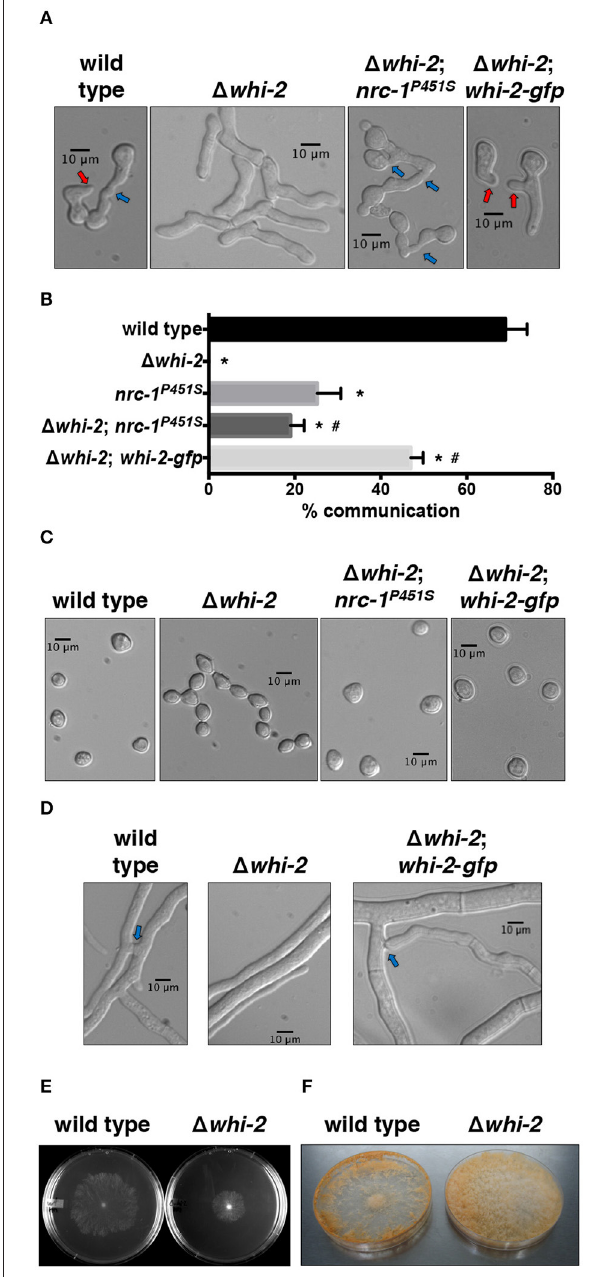
FIGURE 1 | Cell fusion and conidiogenesis defects observed in a 1 whi-2 mutant can be partially rescued by the introduction of a constitutively active allele of nrc-1 . (A,B) Cell-cell communication was analyzed by observing brightfield microscopy (A) of closely positioned germlings 4h post-inoculation. Red and blue arrows indicate conidial anastomosis tubes (CATs) and cell communication/fusion events, respectively. The relative frequency of cell-cell communication is shown in (B) . Error bars represent the standard deviation. * p -value < 0.0001 vs. wild type; # p -value < 0.001 vs. 1 whi-2. (C) Conidial morphology was assessed in WT and whi-2 strains using brightfield microscopy. Note the presence of proconidial chains in the 1 whi-2 strain. (D) Hyphal fusion was evaluated 16h post-inoculation. Blue arrows point to hyphal fusion events. (E,F) Radial growth (E) and sporulation (F) were analyzed in wild type and 1 whi-2 colonies 24h or 7 days after inoculation on Petri dishes,